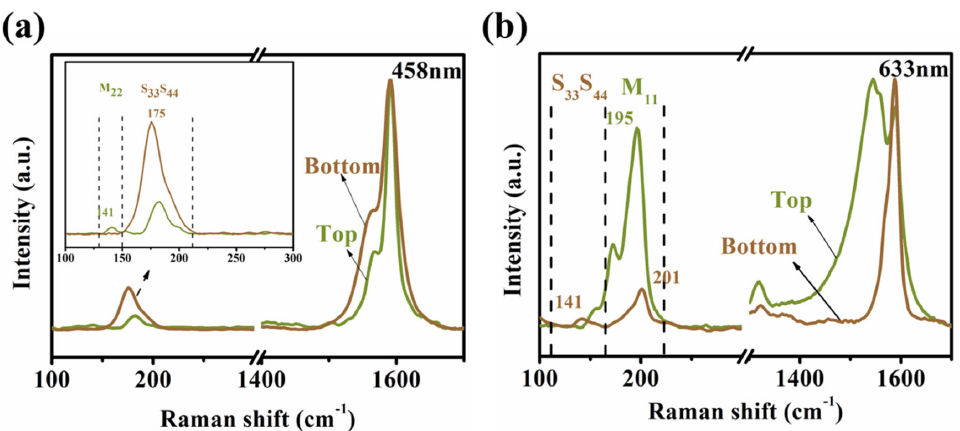
Figure 6. Raman spectra of the SWNTs in the top green layer and the bottom red–brown layer at the excitation of ( a ) 458 and ( b ) 633 nm, respectively, in the ranges of 100–1700 cm − 1 .